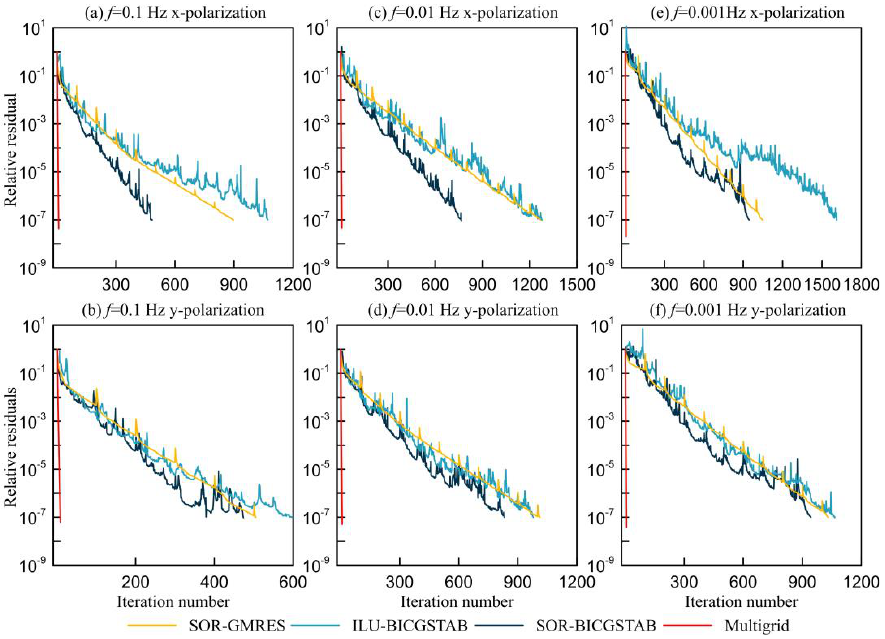
Figure 8 . Convergence curves of SOR-GMRES, ILU-BICGSTAB, SOR-BICGSTAB, and our MG algorithm for the COMMEMI3D-2 model at 0.1, 0.01 and 0.001 Hz. The computation is conducted on the grid of size 128 × 128 × 64, with a DoF of 3211584.